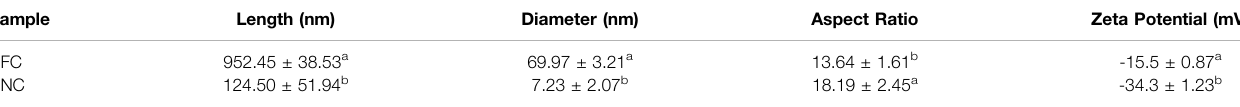
TABLE 1 | Dimensions and zeta potential of NFC and CNC isolated from bamboo shoot processing byproducts. Sample